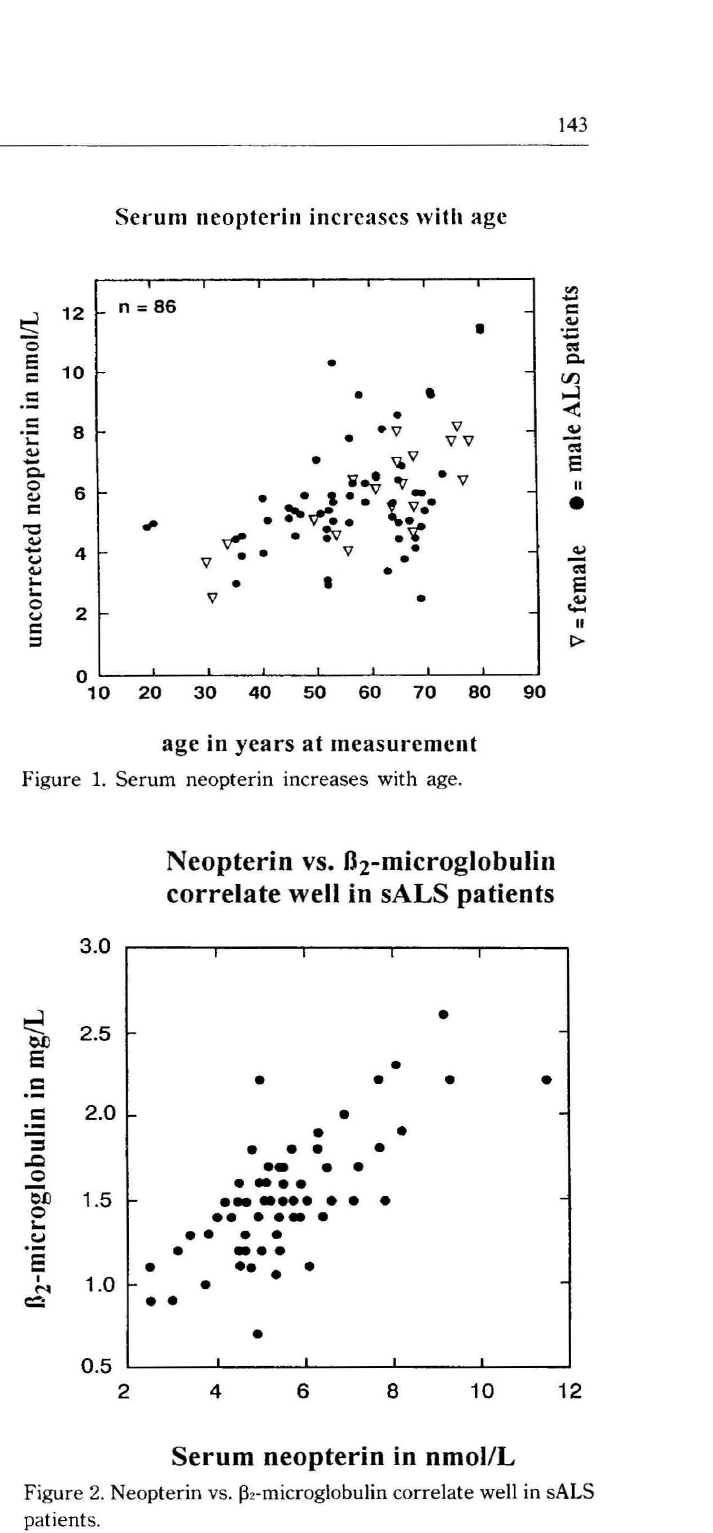
Figure 1. Serum neopterin increases with age.